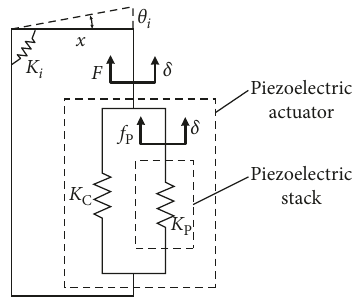
Figure 10: Model of the piezoelectric